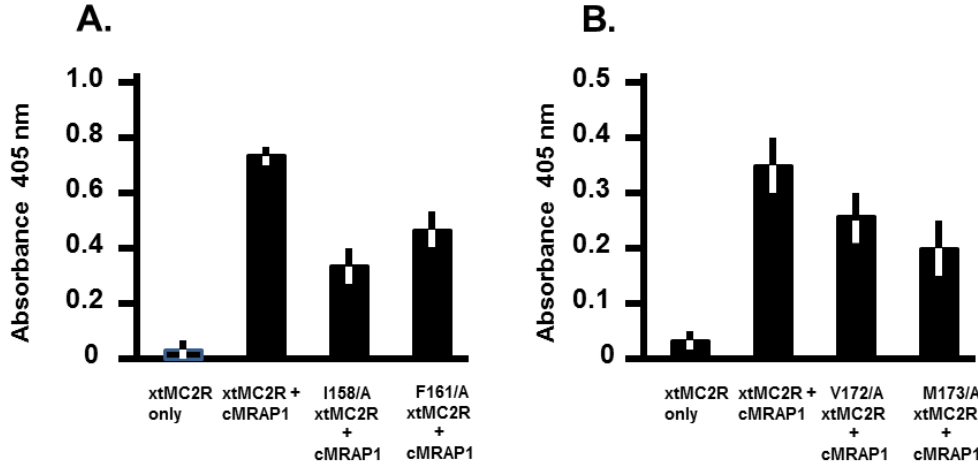
Figure 3. Cell Surface ELISA analysis of xtMC2R mutants I158/A, F161/A, V172/A, M173/A. xtMC2R and xtMC2R mutants, I158/A, F161/A, V172/A, M173/A were separately co-transfected with cMRAP1 in CHO cells and trafficking of the receptor to the plasma membrane was evaluated by cell surface ELISA as described in Material and Methods. ( A ) Negative control, xtMC2R expressed alone; positive control, xtMC2R + cMRAP1, mutants analyzed: I158/A xtMC2R + cMRAP1, and F161/A xtMC2R + cMRAP1. Note that there was a significant increase in the trafficking when xtMC2R was co-expressed with cMRAP1 as compared to xtMC2R expressed alone ( p < 0.001). ( B ) Negative control, xtMC2R expressed alone; positive control, xtMC2R + cMRAP1, mutants analyzed: V172/A xtMC2R + cMRAP1, and M 173 /A xtMC2R + cMRAP1. Note that there was a significant increase in the trafficking when xtMC2R was co-expressed with cMRAP1 as compared to xtMC2R expressed alone ( p < 0.001). Data